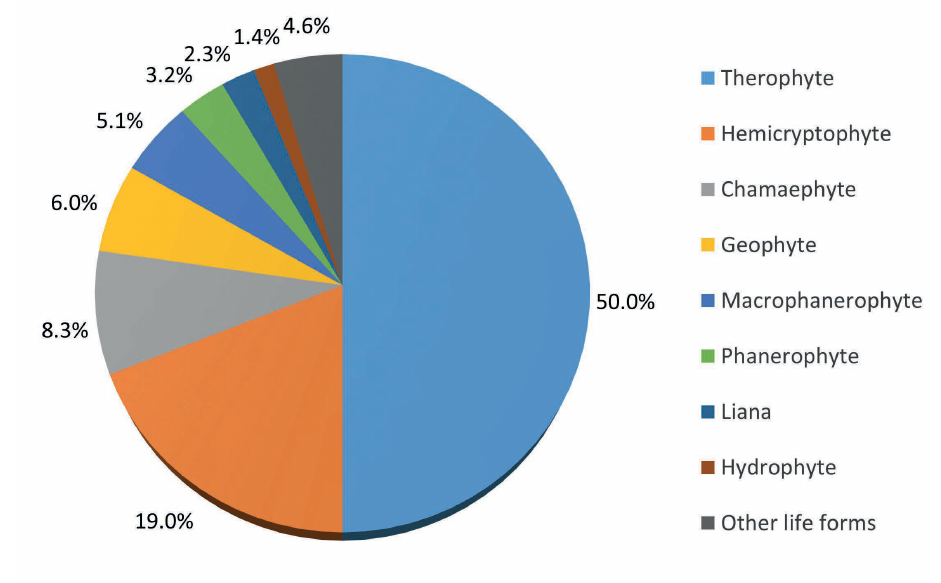
Figure 4 – Relative proportion of families of alien plant species in Anaga Rural Park, Tenerife. The set of families with low representation (43) represent 37.0%.